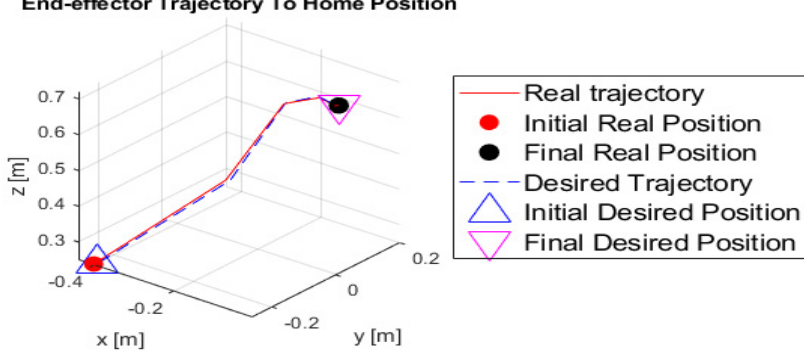
Figure 23. Real and desired trajectory of RM Cyton, for displacement from P / RML to the parking position, using inverse kinematics control. Some frames of real-time control of RM Cytor for picking up work-piece from ARS PeopleBot, based on eye in hand VSS and releasing it on P / RML, based on eye to hand VSS, are presented in Figures 24 and 25,